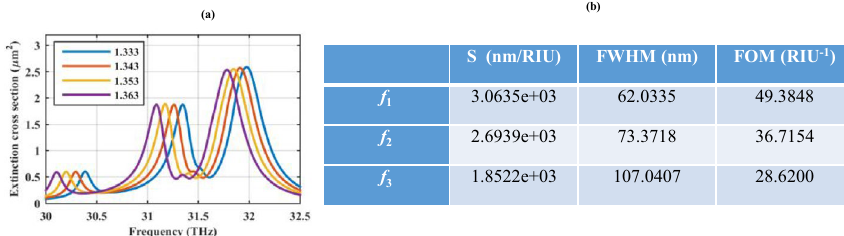
Figure 8. ( a ) Investigating the refractive index sensing capability of the hexamer cover by changing the refractive index of the gray layer in Fig. 5a from n = 1.333 to 1.363 and ( b ) the sensor parameters. The initial design parameters are as follows: r c = 500 nm, ε c = 2, r s = 100 nm, h = 250 nm τ = 1.5 ps, and μ c = 0.5 eV. The spherical particles are considered hollow. f 1 – f 3 respectively denote the first to the third resonance frequencies.